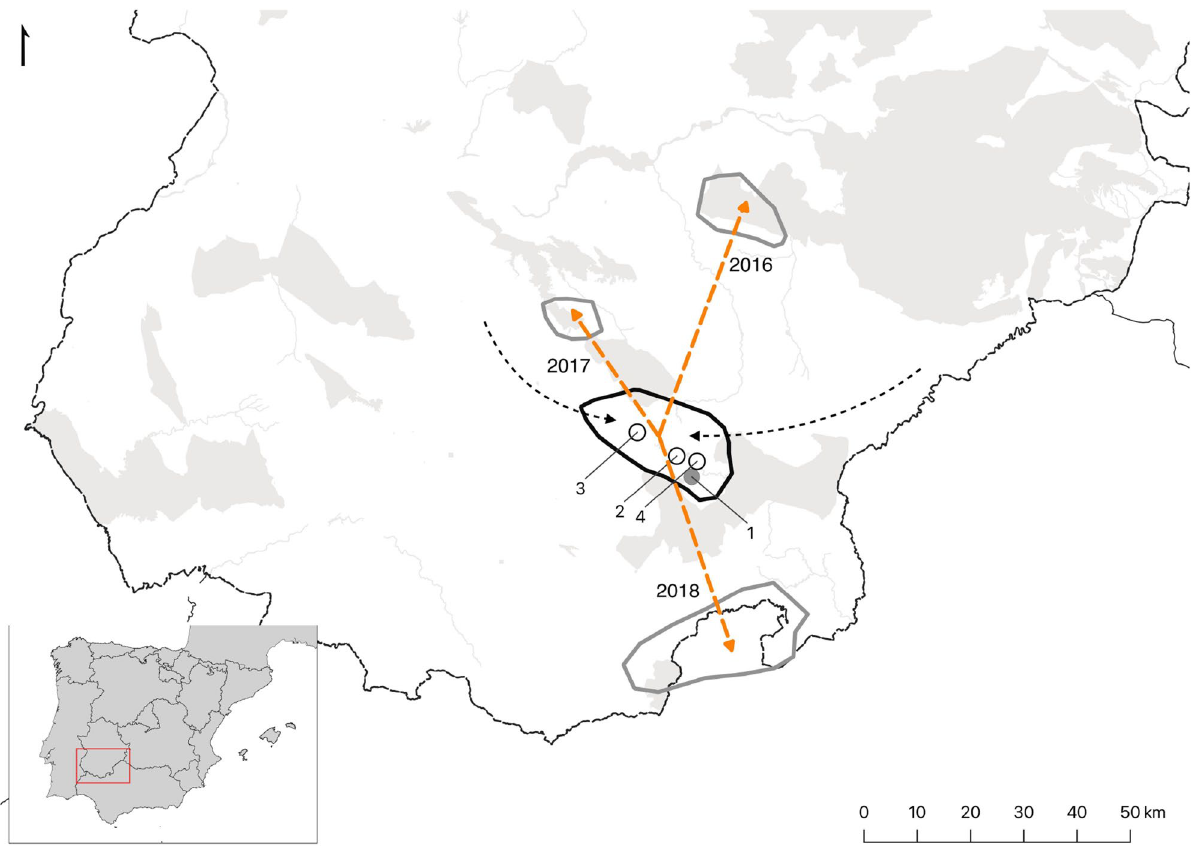
Figure 1. Study area showing the reintroduction area delimited by the black line, and colonized areas by grey lines. Release sites are represented (grey dot = soft release; white dot = hard release). Dashed line is the translocation of individual M03. The years in which stable territories were established in the colonized areas are indicated. Light grey polygons represent Nature 2000 Network. The maps were generated using QGIS 3.20.0 (https:// www. qgis. org).